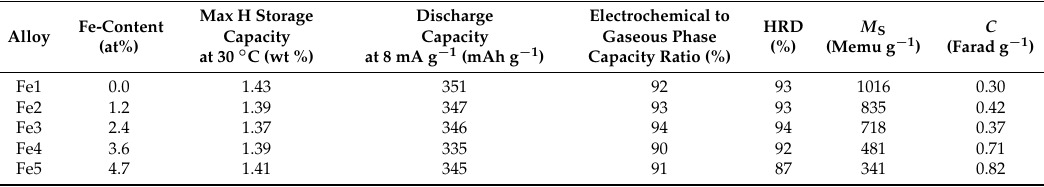
Table 1. Summary of the compositions and properties of the superlattice hydrogen absorbing alloys (HAAs) used in this study. The gaseous phase maximum hydrogen storage capacity was obtained at 6 MPa hydrogen pressure. The electrochemical capacity was taken from the 2nd cycle at a discharge current of 8 mA g − 1 with a cutoff voltage of 0.9 V against a standard Ni(OH) 2 positive electrode. HRD represents the ratio of the capacity at a discharge current of 200 mA g − 1 to that at 8 mA g − 1 . M S is the saturated magnetic susceptibility, which reflects the total volume of the metallic nickel clusters imbedded in the alloy surface. C is the surface double-layer capacitance obtained from alternative current (AC) impedance